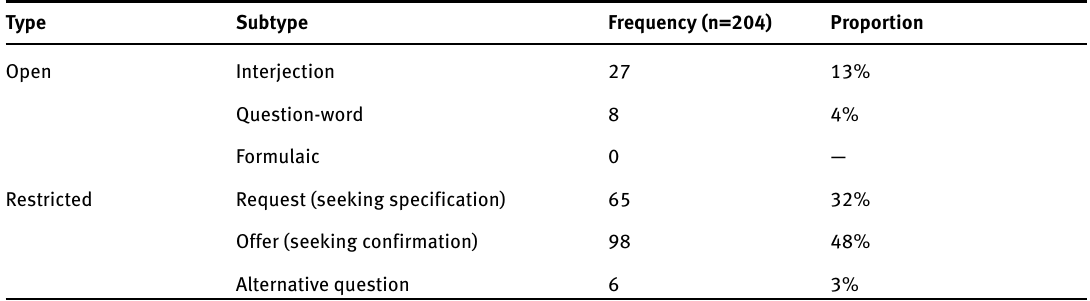
Table 3 Types of repair initiators and their frequency in the Russian